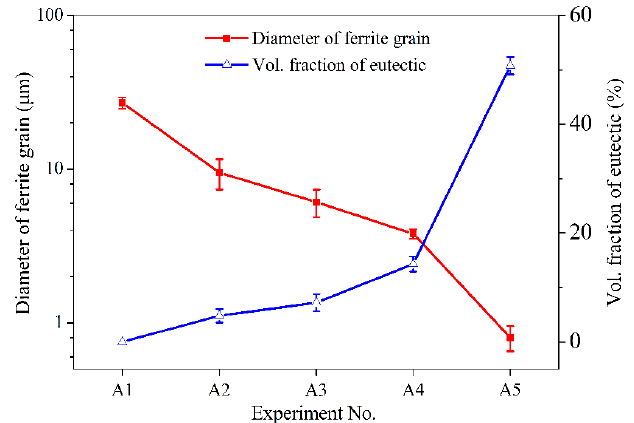
Figure 7. Diameter of ferrite grain and volume fraction of the eutectic in the deposited alloys at different concentrations of Fe–Cr–B–Si–Mo powder.